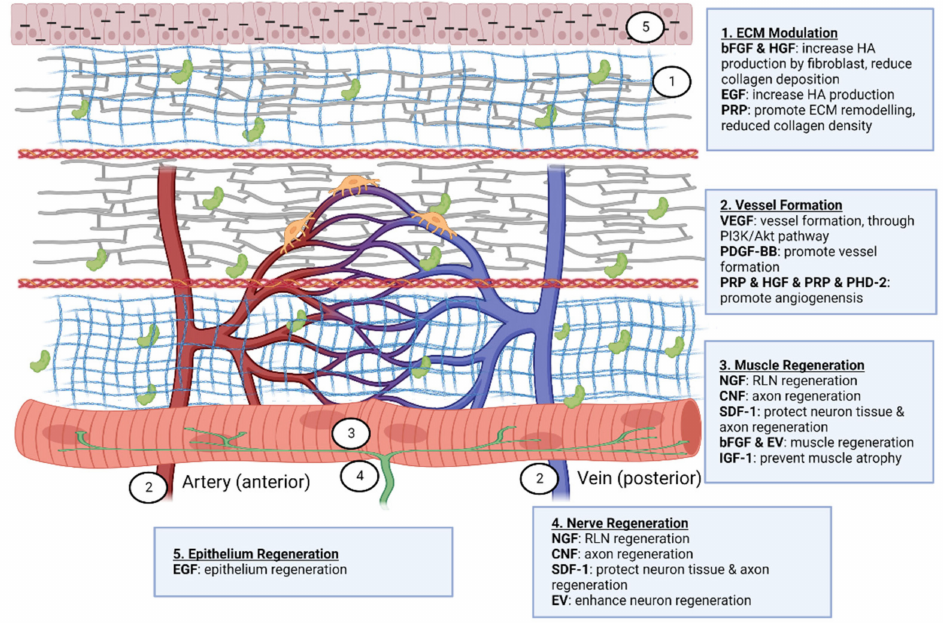
Figure 8. Therapeutic effect of biomolecules on vocal fold regeneration. Created with Biorender.com (accessed on 24 October